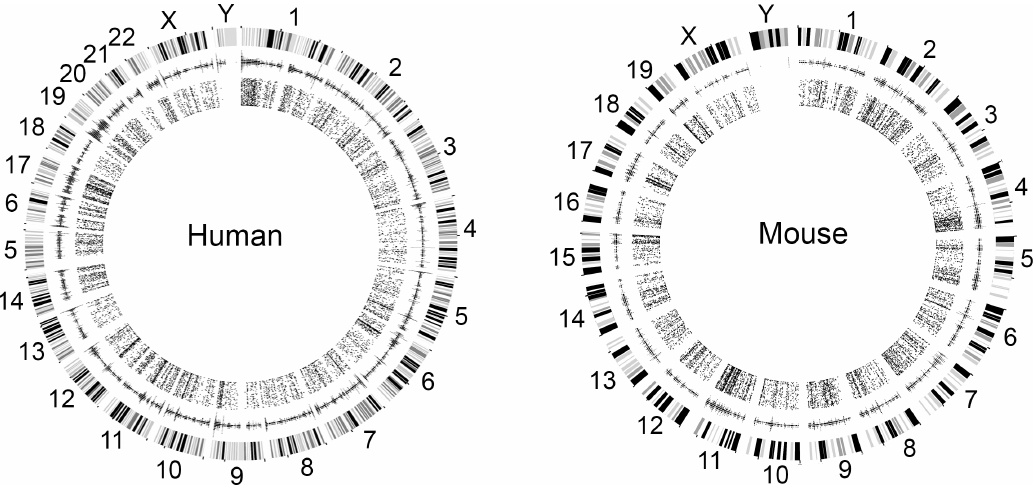
Fig 1. Location of conserved Illumina human MethylationEPIC probes and CpG densities in the human and mouse genomes. The outer circle displays the chromosomes and circular karyotype of the human and mouse genomes. CpG island (CGI) density is shown in the second circle. The innermost circle displays the positions of CpGs targeted by the 13,665 conserved